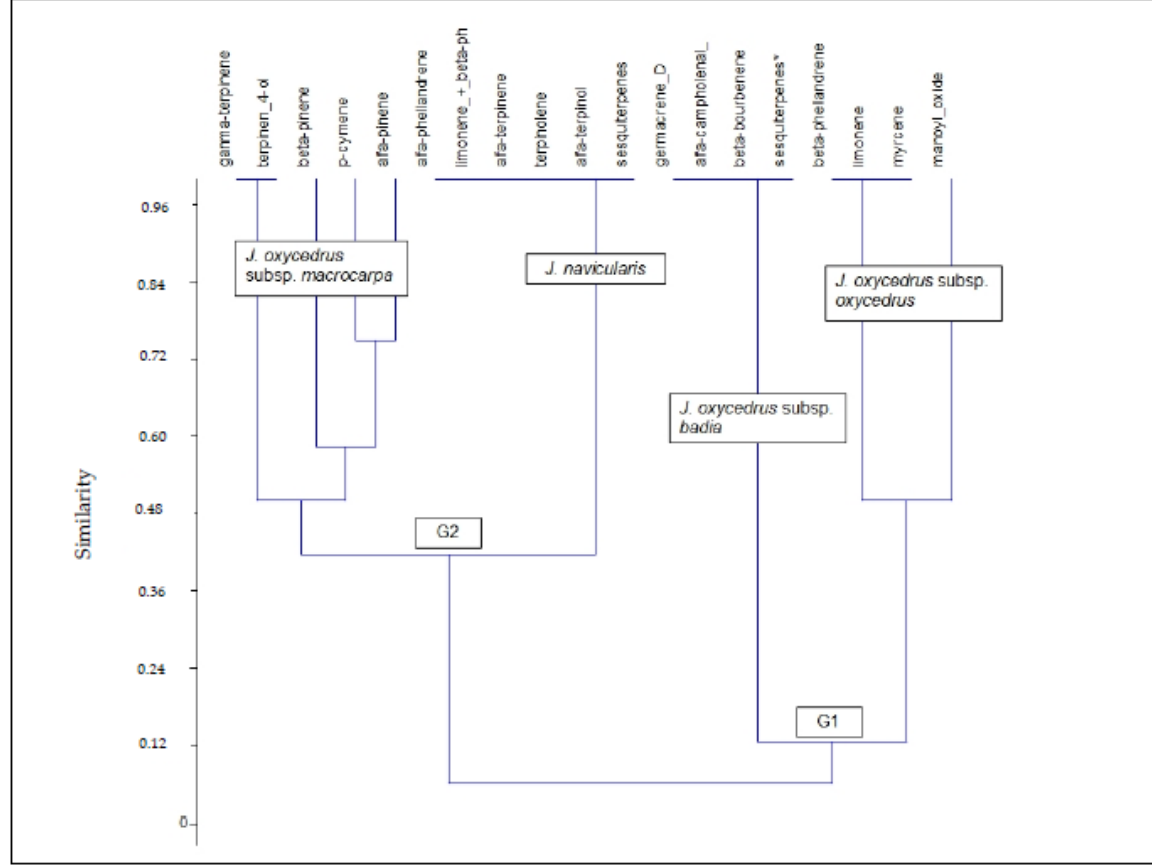
Figure 3. Similarity analysis between the taxa Juniperus oxycedrus subsp. oxycedrus, J. oxycedrus subsp. badia, J. oxycedrus subsp. macrocarpa and J. navicularis. Table 3. r- Pearson. The values in bold are different from 0 with a level of significance of alpha = 0.05. Types of oils con- sidered: 1. Alpha-pinene, 2. Limonene, 3. Beta-pinene, 4. Myrcene, 5. P-cymene, 6. Beta-phellandrene, 7. Monoyl oxide, 8. Germacrene D, 9. Alpha-campholenal, 10. Beta-bourbenene, 11. Sesquiterpenes exclusives, 12. Gamma-terpinene, 13. Ter- pinen 4-ol, 14 Alpha-phellandrene, 15. Limonene + beta-phellandrene, 16. Alpha-terpinene, 17. Terpinolene, 18. Alpha- terpinol, 19. Sesquiterpenes.